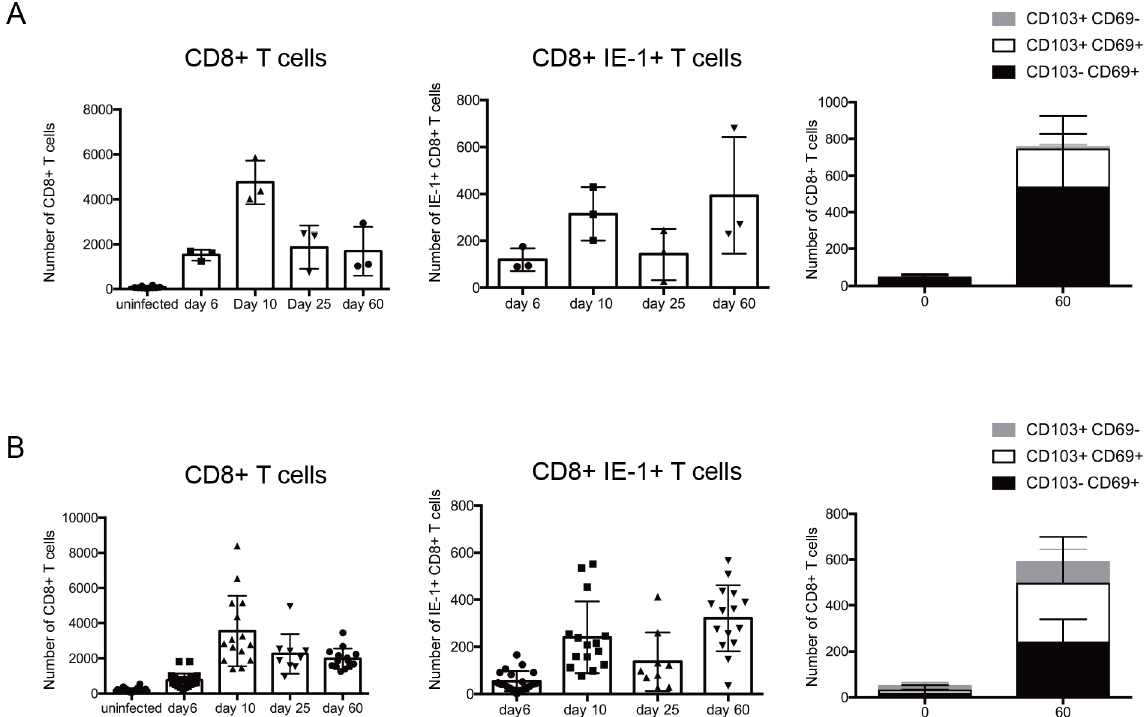
Fig 8. Virus-specific CD8 + T cells infiltrate and accumulate in the iris and retina after systemic MCMV infection and form tissue resident memory (T RM ) populations. Mice were infected with MCMV, and at the indicated times pi single cell preparations were prepared and stained for T cell markers. (A) The number of CD8 + T cells, CD8 + IE1 + antiviral T cells and CD8 + IE1 + CD103 +/- CD69 +/- T cells are graphed as mean ± SEM for ( A ) the iris and ( B ) the retina. Samples represent n = 6 for uninfected mice, and n = 15 for MCMV infected mice for each time point from 3 independent experiments. Iris samples were pooled from 5